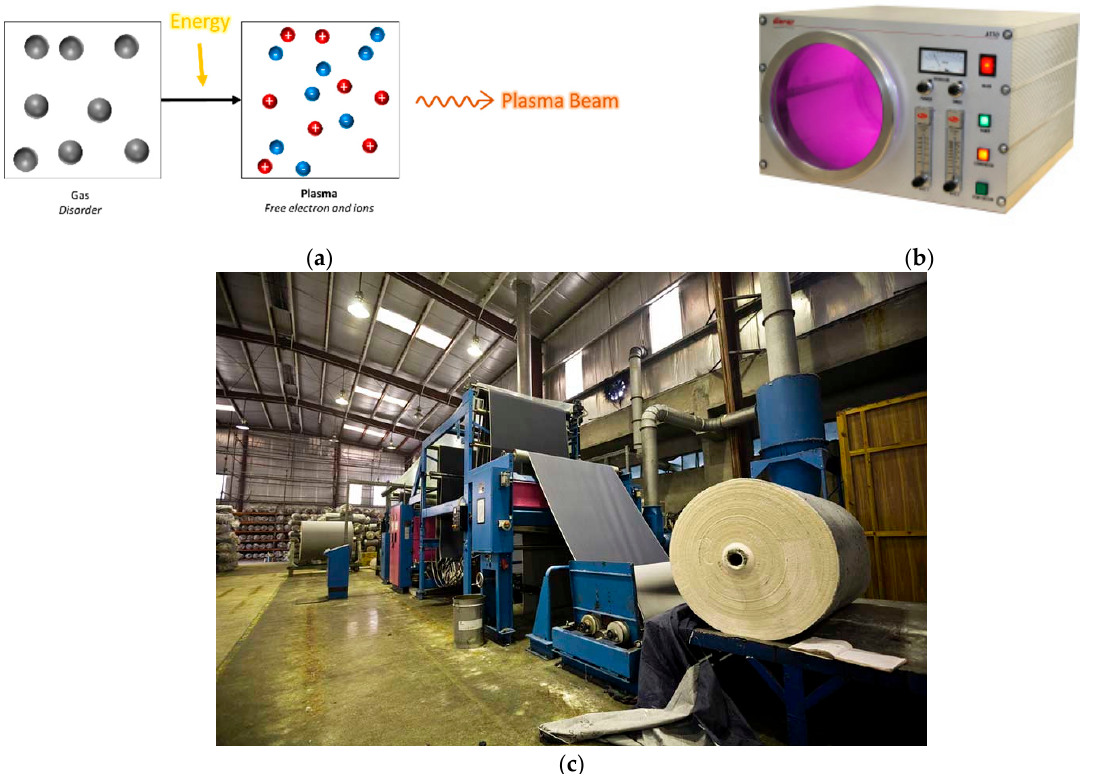
Figure 11. ( a ) Simplified scheme of the plasma formation; ( b ) picture of a plasma generator designed for lab work Rotalab™ ; ( c ) picture of a large ‐ scale plasma treatment chain Henniker™ .